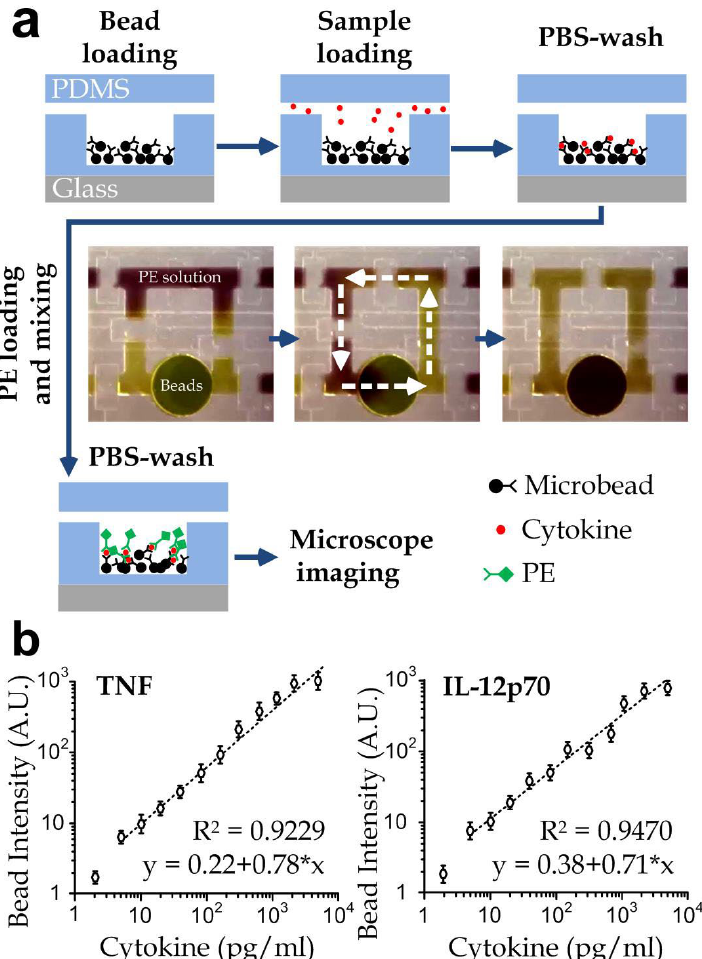
Figure 2. ( a ) Cytokine detection procedures of the integrated microfluidic immunoassay device. Cytokines produced by NPC and immune cells on-chip were transferred from the cell culture region to the cytokine detection arrays, and specifically captured by the pre-loaded antibody conjugated microbeads, followed by washing with PBS buffer. To quantify the cytokine concentrations on-chip, fluorescent phycoerythrin (PE)-conjugated detection antibodies were mixed with the cytokine-binding microbeads using an integrated micromixer (middle panel, representative microscope images), causing the fluorescence change on the microbeads as a readout of binding events. Finally, the fluorescence change was quantified by microscope imaging, and the cytokine concentration was calculated according to the calibration curves. ( b ) The calibration curve of two different cytometric microbeads for TNF and IL12p70 in the microfluidic device by challenging microbeads with different concentrations of cytokines. The data points for 2.4 pg/mL cytokine concentration are not included in the fitting line. Each data point was obtained from the average value of n > 100 from 3 repeated measurements. All error bars represent the standard